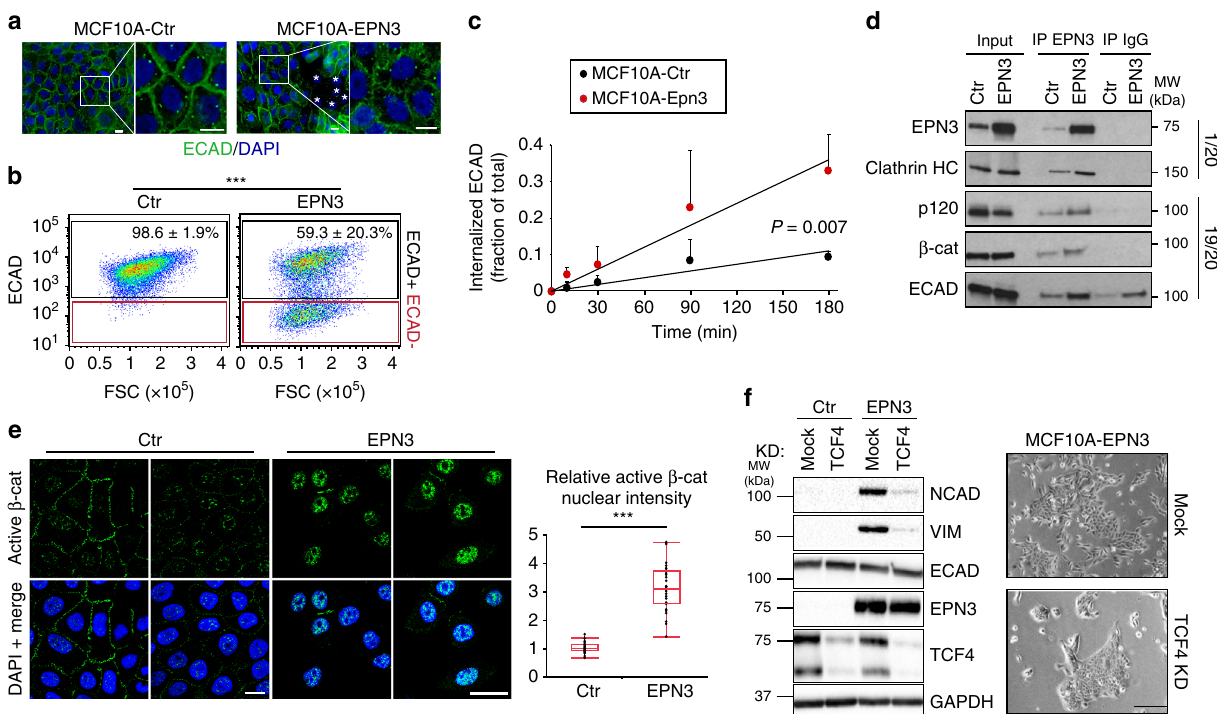
Fig. 4 EPN3 stimulates ECAD internalization and β -catenin/TCF4-dependent EMT. a IF staining of ECAD (green) in the indicated cells, at con fl uency. Blue, DAPI. Asterisks, cells lacking ECAD staining. Bar, 10 μ m. b Representative FACS analysis of the indicated cells stained in vivo for ECAD. Black and red gates represent ECAD-positive and -negative cells, respectively, and have been set according to the unstained control samples. FSC, forward scatter. Mean percentage of ECAD-positive cells ± S.D. ( n = 18) is reported. P value, Student ’ s t test two-tailed. See also Supplementary Fig. 4B. c Time course of ECAD internalization in the indicated cells measured by FACS analysis. Fraction of mean fl uorescence intensity of internalized ECAD signal over the total ± S.D. ( n ≥ 3) is reported. Student ’ s t test, two-tailed. d Lysates (1 mg) from the indicated cells were subjected to immunoprecipitation with anti-EPN3 Ab or with a control IgG. Three independent EPN3 IPs were performed to check p120, β -cat, or ECAD binding. Clathrin binding was analyzed in the same IP experiment of β -cat. In each case, ef fi ciency of EPN3 IP gave comparable result (one representative EPN3 IP/IB is shown). In total, 1/20 and 19/20 of the IPs were loaded separately and subjected to IB analysis with the indicated Ab. Input is 20 µ g for the 1/20 panel, and 1 µ g for the 19/20 panel. Right, MW markers. Results are representative of at least two independent experiments. e Left, representative confocal images of the indicated cells stained for active β -catenin. Blue, DAPI. Bar, 30 µ m. Right, box plot analyses of relative nuclear fl uorescence intensity of active β -catenin per cell in MCF10A-Ctr ( N = 34) and MCF10A-EPN3 cells ( N = 36) in a representative experiment ( n = 3). Data were normalized on the median value of nuclear fl uorescence intensity in MCF10A-Ctr. P value, each pair, Student ’ s t test, two-tailed. f TCF4 was silenced in the indicated cells. Negative control, mock transfection. Left, cell lysates were IB with the indicated Ab. GAPDH, loading control. Left, MW markers. See Supplementary Fig. 8C for quantitation and statistics. Right,